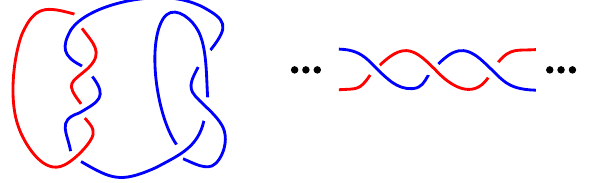
Fig. 3. Link diagrams of a usual link (left) and linearly very long double helix (right). Both are admitted as 2-component links.